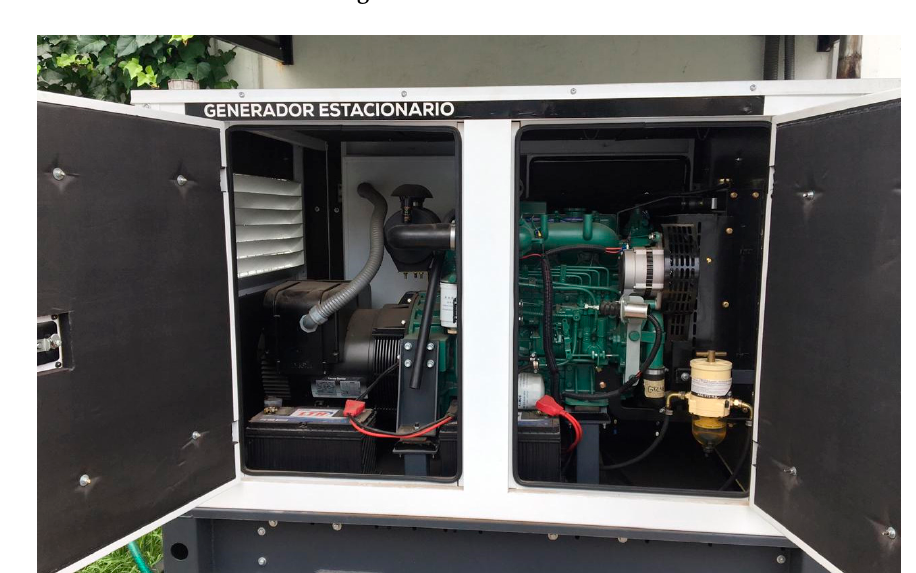
Figure 5. Biodiesel blends. Appl. Sci. 2020 , 10 , x FOR PEER REVIEW